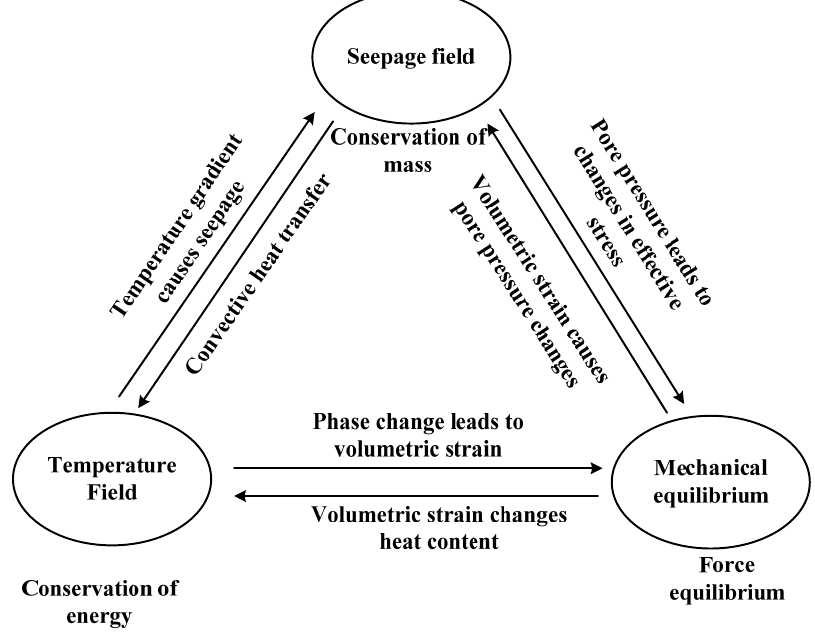
Figure 1. Coupling relationship of physical fields in soil freezing.